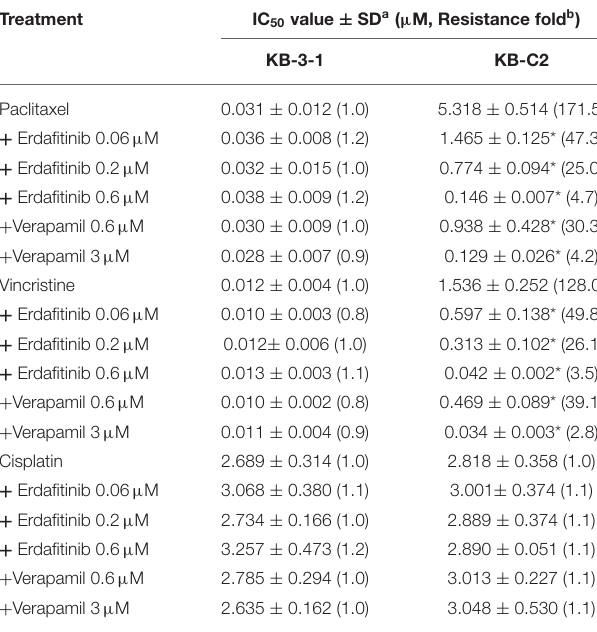
TABLE 1 | Erdafitinib reversed ABCB1-mediated MDR in KB-C2 cells. Treatment